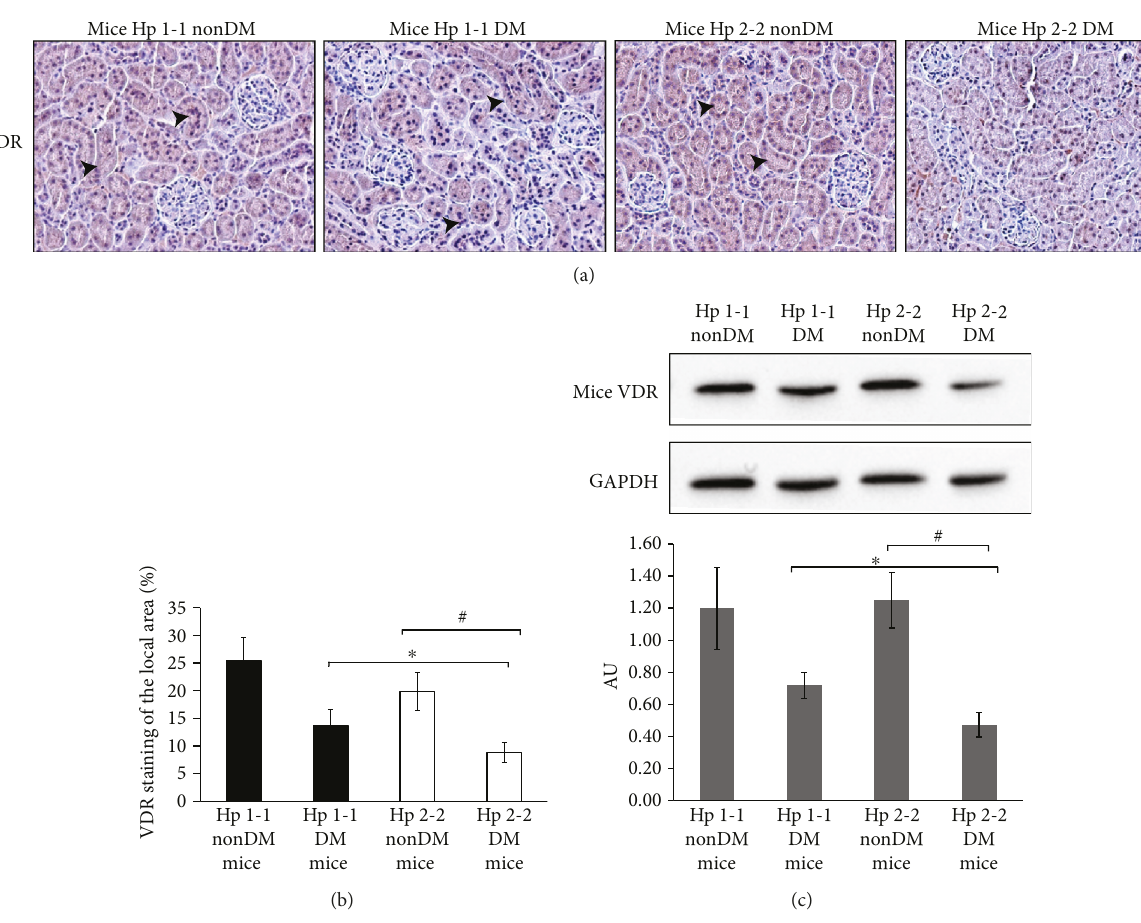
Figure 5: Renal vitamin D receptor (VDR) expression in nondiabetic (nonDM) and diabetic (DN) mice. (a) Renal sections from Hp 1-1 and 2-2 mice were subjected to IHC of VDR (brown, indicated by arrowheads). (b) There was a signi fi cant decrease in the percentage of the VDR- stained area in the tubules of Hp 2-2 DM renal sections compared with Hp 1-1 DM ( ∗ p < 0 05 ) or with nonDM Hp 2-2 renal sections ( # p < 0 05 ). (c) Western blot analysis of VDR with the mice renal lysate. Proteins were detected by immunoblotting with antibodies against VDR and GAPDH. The values represent the mean ± SEM for 3 independent experiments subjected to 2-tailed, 2-sampled unequal variance Student ’ s t -test, with ∗ p = 0 001 compared with Hp 2-2 nonDM and # p = 0 005 compared with Hp 1-1DM. AU: arbitrary